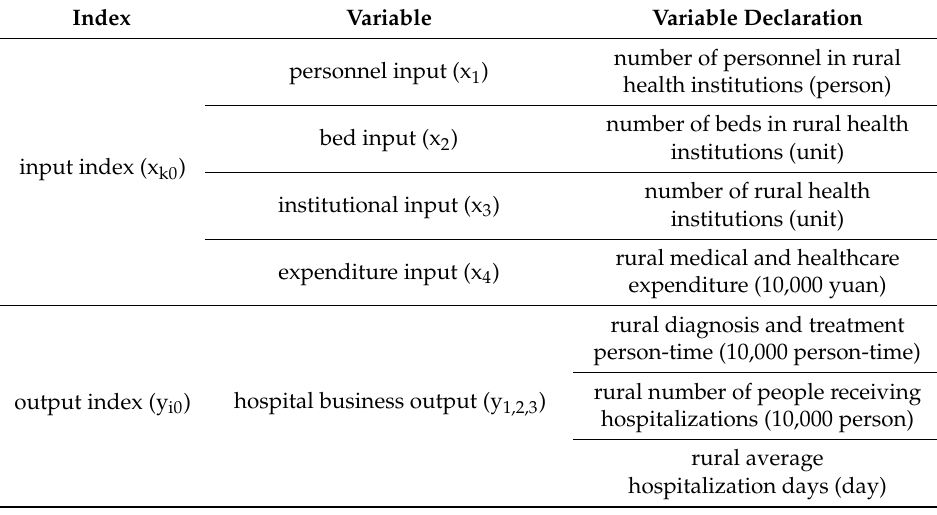
Table 1. Evaluation index system of rural public health resource allocation e ffi ciency in